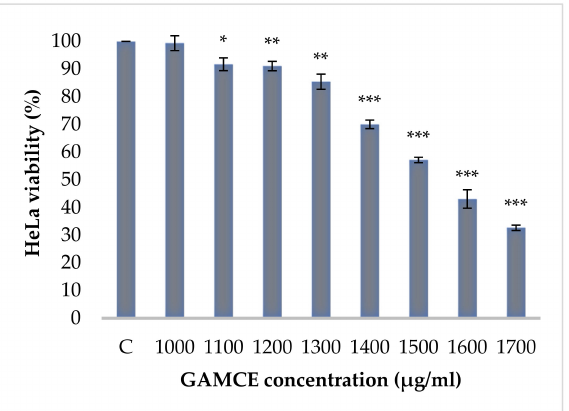
Figure 1. HeLa cells, control group (C = 100% viability) was not treated at all; experimental groups were treated with different concentrations (1000, 1100, 1200, 1300, 1400, 1500, 1600, and 1700 µ g/mL) of GAMCE for 24 h. The test result of IC 50 of GAMCE was 1.55 ± 0.01 mg/mL. The data are shown as Mean ± SE. Mean significant difference (* p < 0.05, ** p < 0.01, *** p < 0.005) compared to control.